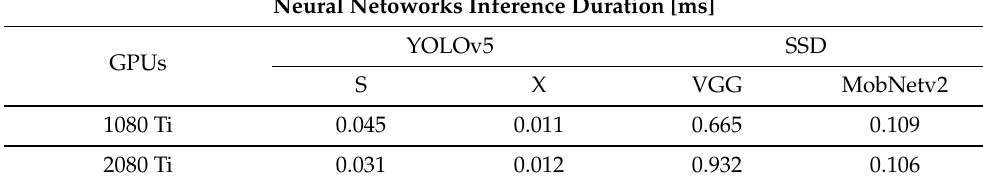
Table 9. Inference time (in seconds) of the used object detectors on the NVIDIA 1080 Ti and NVIDIA 2080 Ti